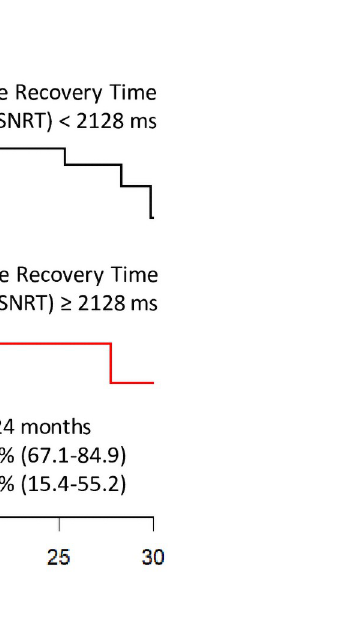
Fig 2. Kaplan–Meier analysis of the atrial fibrillation free survival rate.